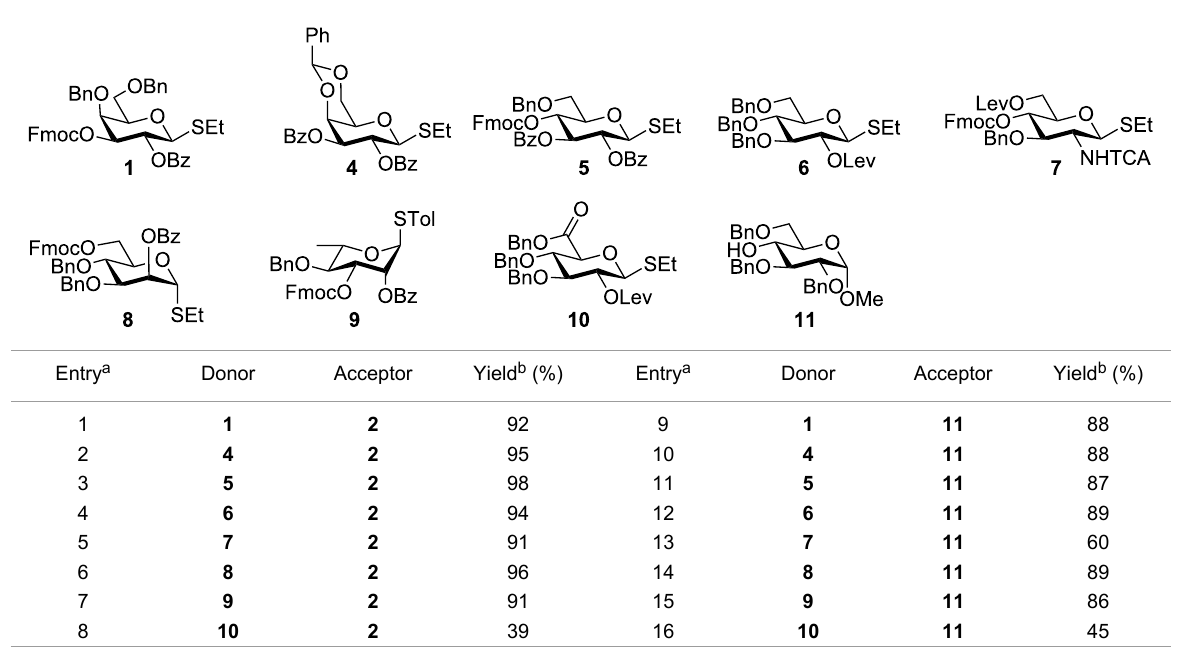
Table 2: 1,2- Trans -glycosylation activated by DBDMH with a variety of building blocks.